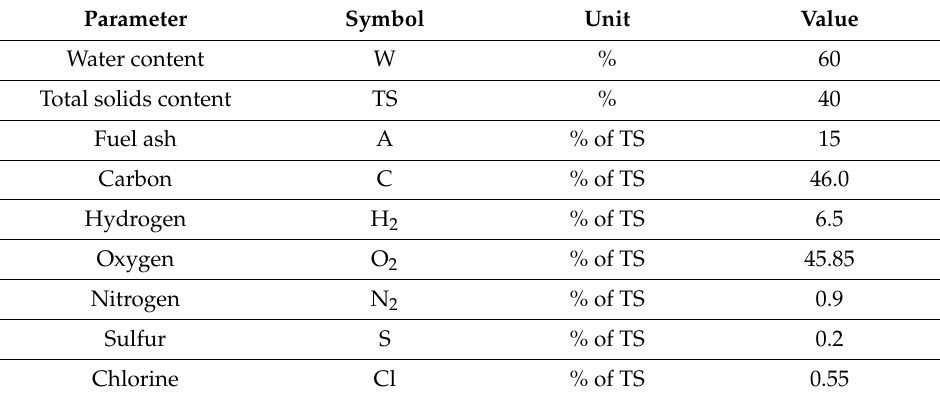
Table 2. Elementary analyses of the composition of raw waste in